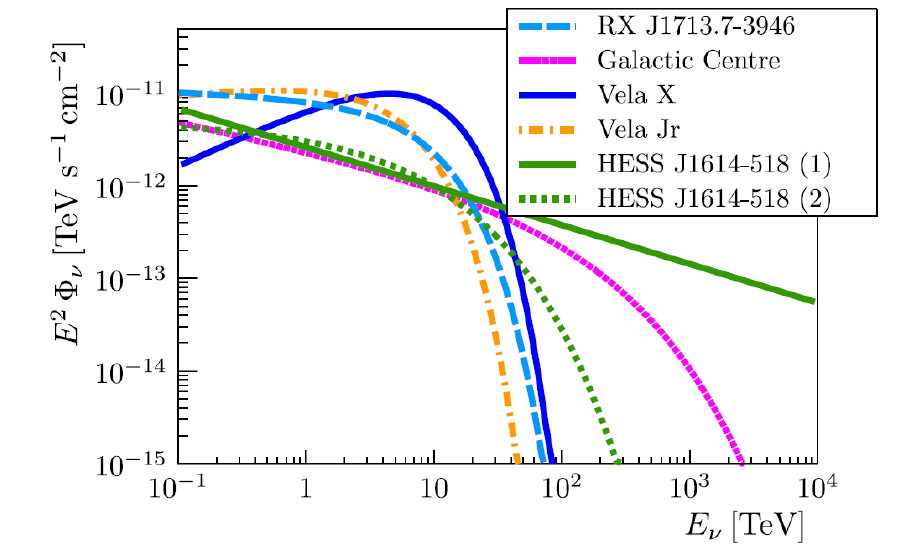
Figure 2. Prediction of the ν µ fluxes for different galactic sources used in the sensitivity studies of the KM3NeT collaboration